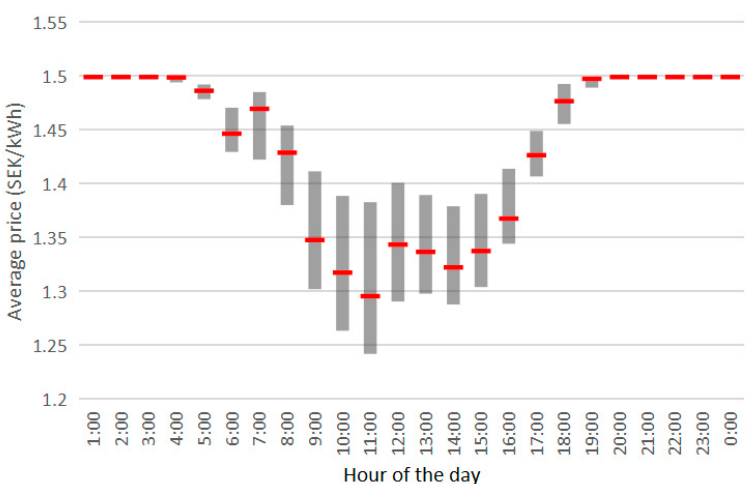
Figure 5. Self-sufficiency within the micro-grid.